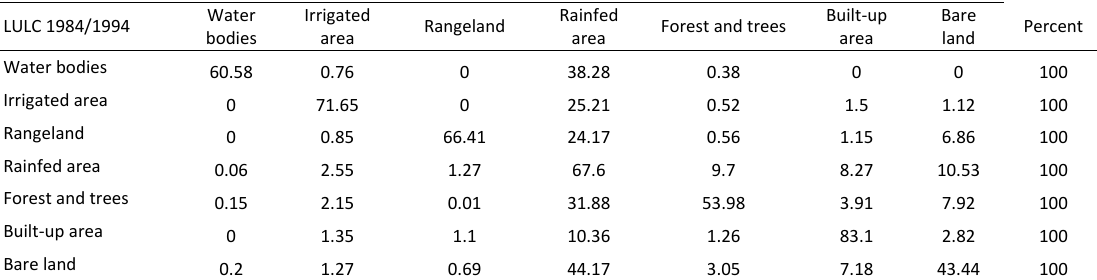
Table 6a: Probability of transition class for LULC 1984-1994 (round one)